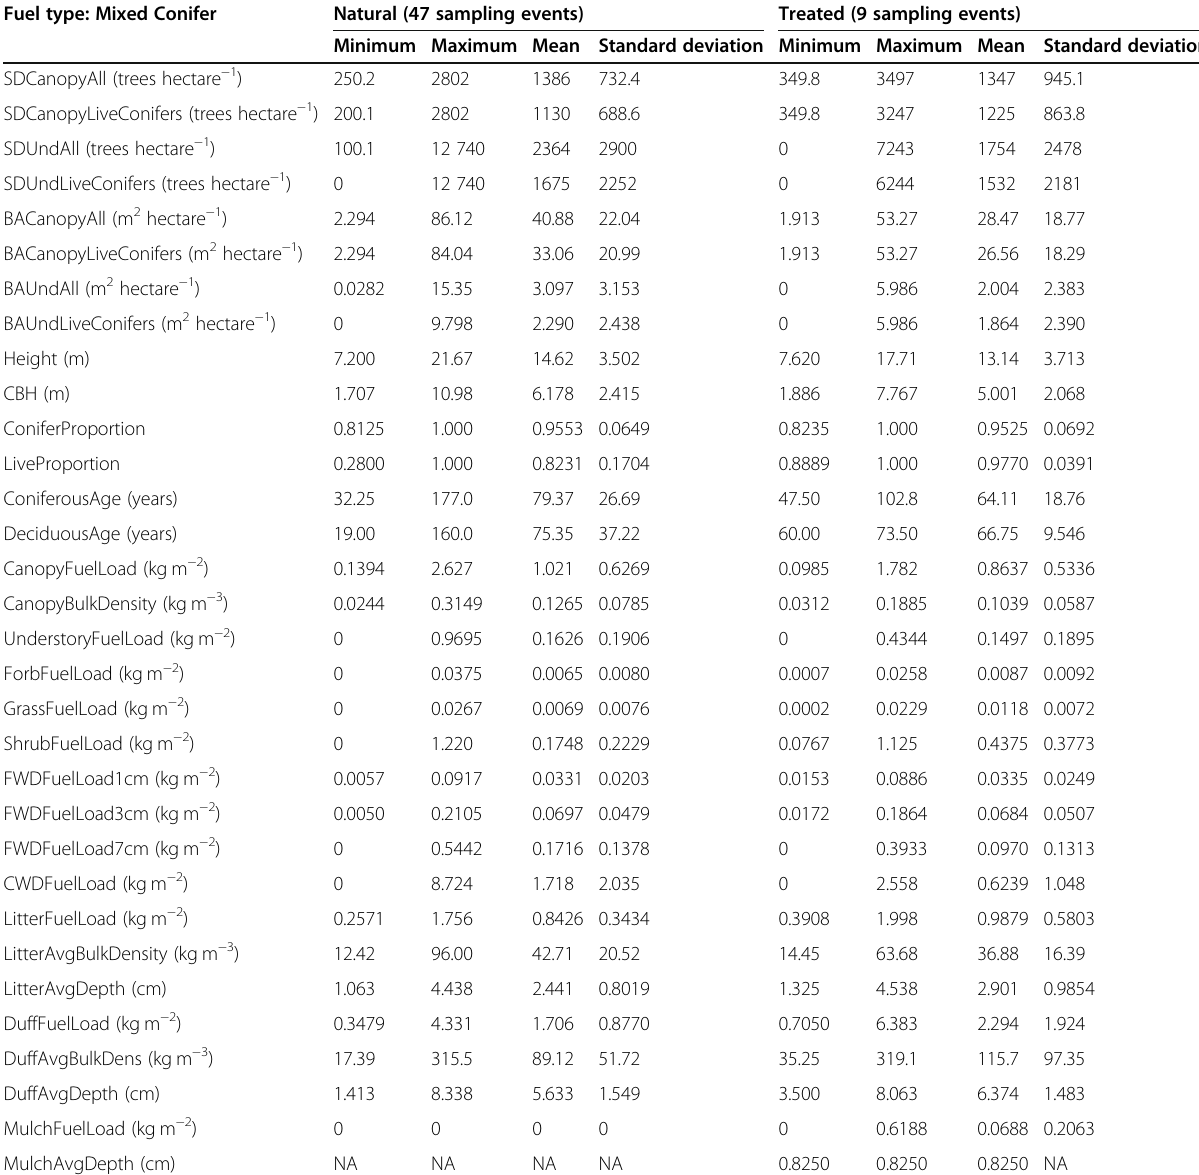
Table 5 Summary tables describing the minimum, maximum, mean, and standard deviation for several stand level features for each fuel type and treatment status by fuel type: Mixed Conifer. It should be noted that the number of sampling events for each category is not necessarily the number of sampling events contributing to the computation. For example, a sampling event might not have any deciduous trees and therefore would not contribute to the computation of statistics about the age of deciduous trees. A value of NA indicates that there were zero — or possibly one in the case of standard deviation — sampling events contributing to the computation. Values were rounded to four significant figures, up to four decimal